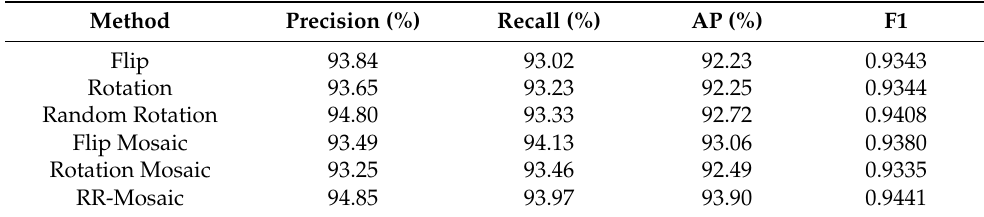
Table 5. Detection results with different data augmentation methods.